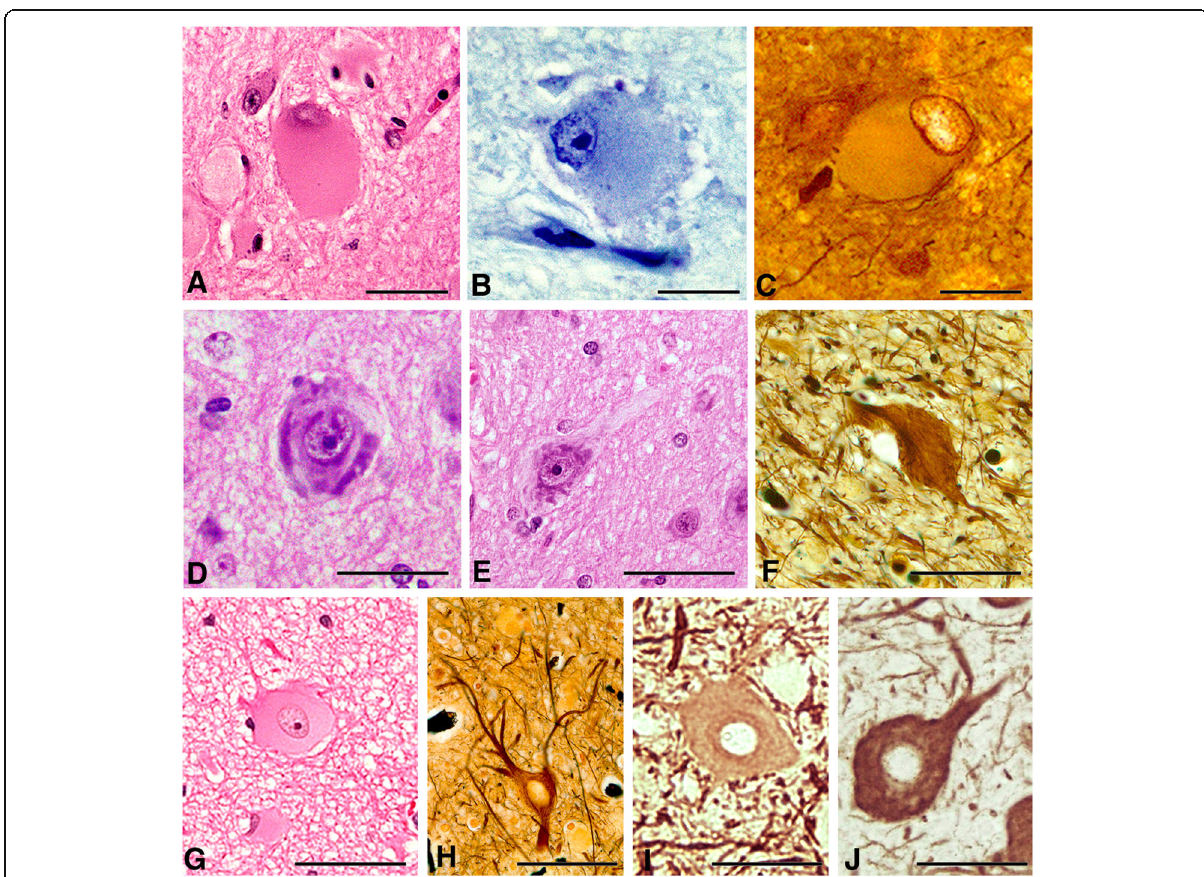
Fig. 2 Identification of balloon cells, dysmorphic and hypertrophic neurons. BCs presented large perikaria and eccentric nuclei upon H&E ( a ), cresyl violet ( b ) and silver staining by the Bielschowsky ’ s method ( c ). Nucleolus was prominent ( b ), and the cytoplasm was homogeneous ( a, b, c ), glassy and eosinophilic by H&E staining, and without a detectable Nissl substance ( a ). DNs exhibited large cell bodies and nuclei ( d, e, f ), and Nissl substance was characteristically clumped or clumped and displaced towards the cell membrane ( d, e ). DNs neurons presented an eccentric nucleus, due to filament accumulation ( f , silver impregnation). HyNs were as large as DNs, but their large nucleus was central ( g, h, i, j ), and Nissl substance was either not observed ( g ) or appeared as usual. HyNs were decorated by anti-neurofilament proteins ( i ) and SMI 311 antibodies ( j ), which are markers of mature neurons. Cases: 9, a and b ; 1, c ; 11, d, f ; 16, e ; 10, g, i, j ; 8, h . H&E staining: a, d, e, g ; Cresyl violet staining: b ;